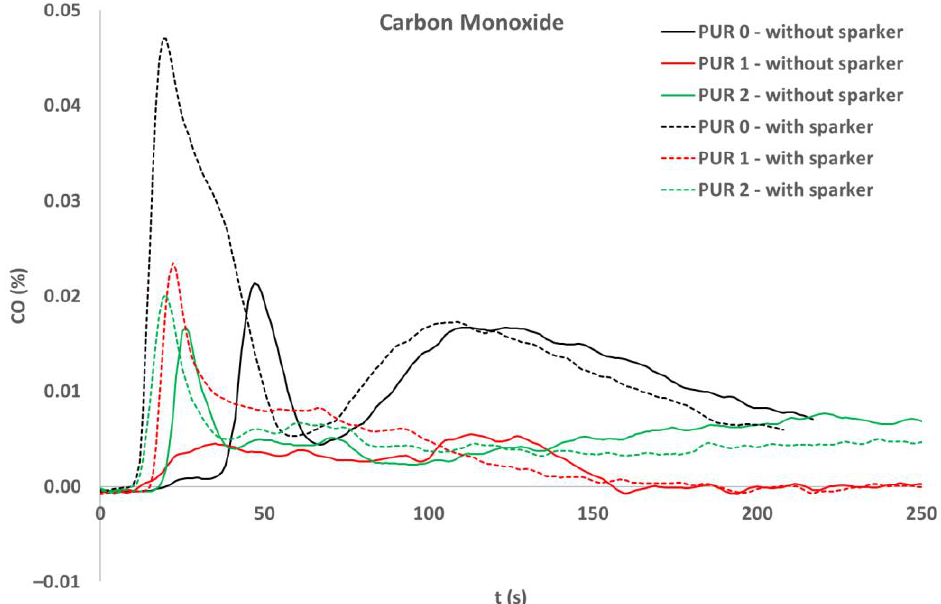
Figure 11. Carbon monoxide release, during exposure of the PURs to the 40 kW/m 2 of heat flux; self-ignited and ignited with a spark igniter.